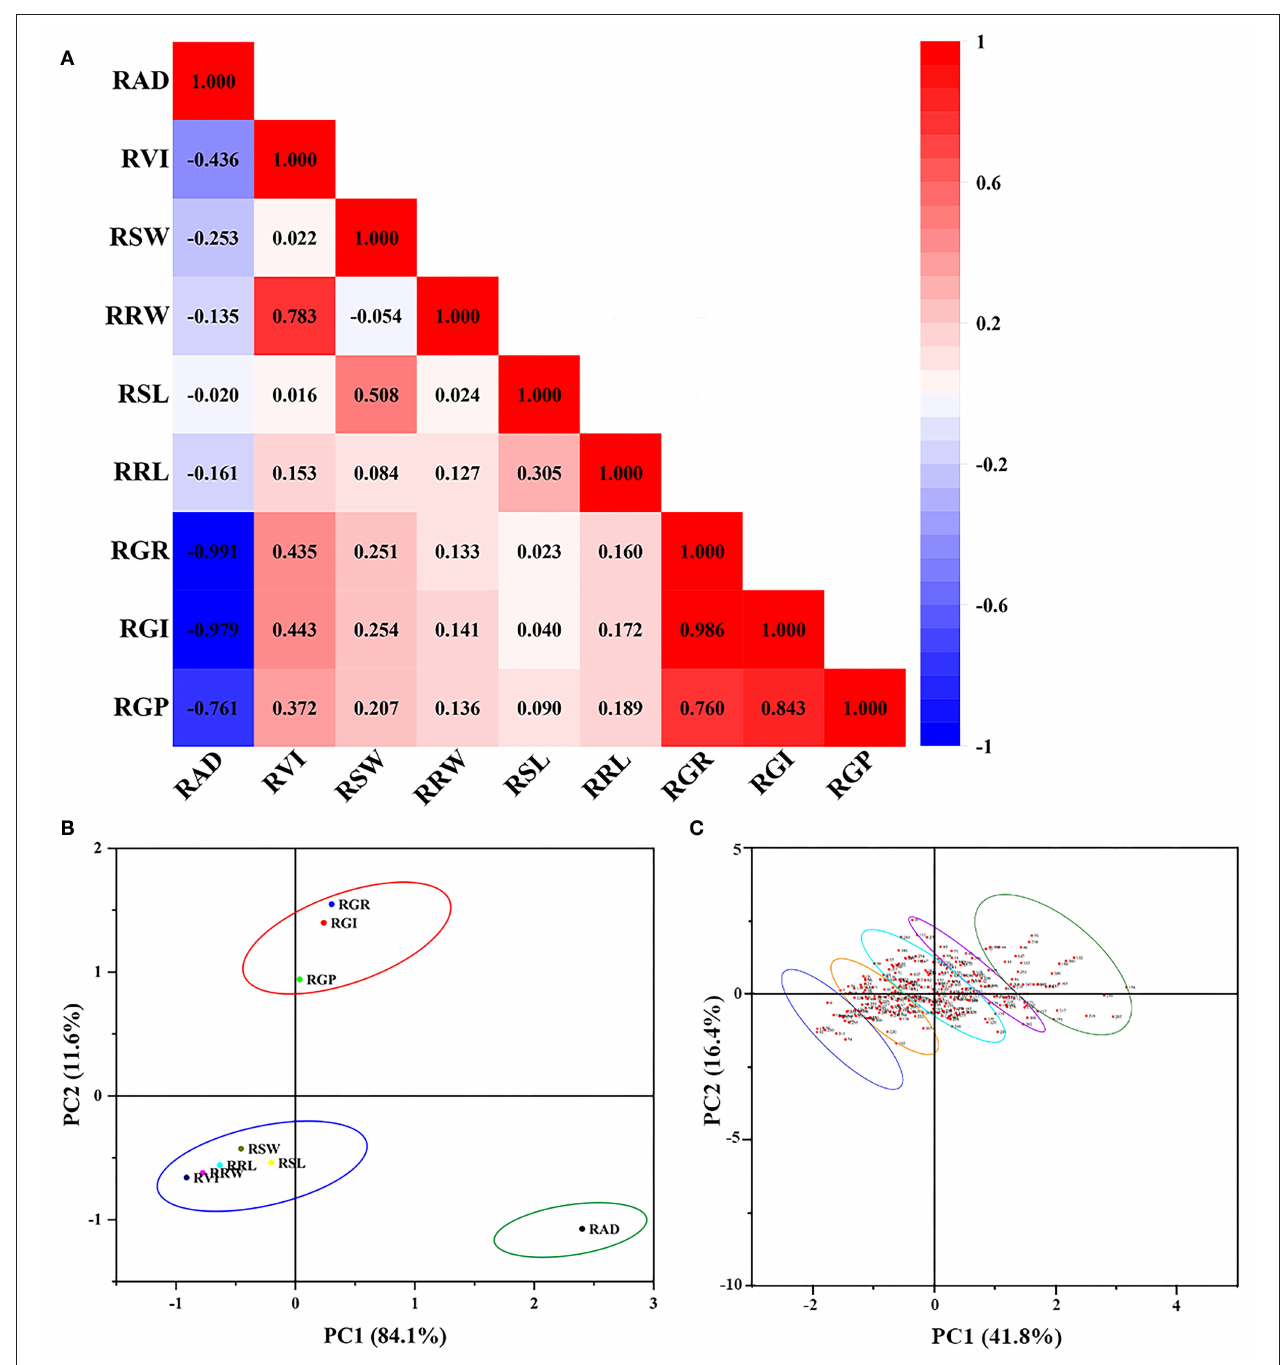
FIGURE 1 | PCC and PCA from 296 genotypes at germination stage. PCC, Pearson’s correlation coefficients; PCA, principal component analysis. (A) Pearson’s correlation coefficients of all traits. (B) Principal component analysis of all traits. (C) Principal component analysis of 296 genotypes. RAD, relative alkali damage rate; RVI, relative vigor index; RSW, relative bud fresh weight; RRW, relative bud fresh weight; RSL, relative bud length; RRL, relative root length; RGR, relative germination rate; RGI, relative germination index; RGP, relative germination